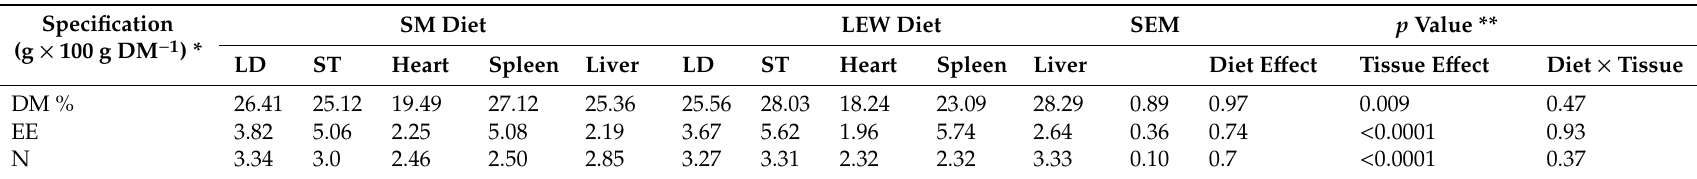
Table 4. E ff ect of dietary extruded linseed:walnut meal 50:50 (wt / wt) mix on chemical composition in longissimus dorsi (LD) and semitendinosus (ST) muscles, heart, spleen, liver and cecum.